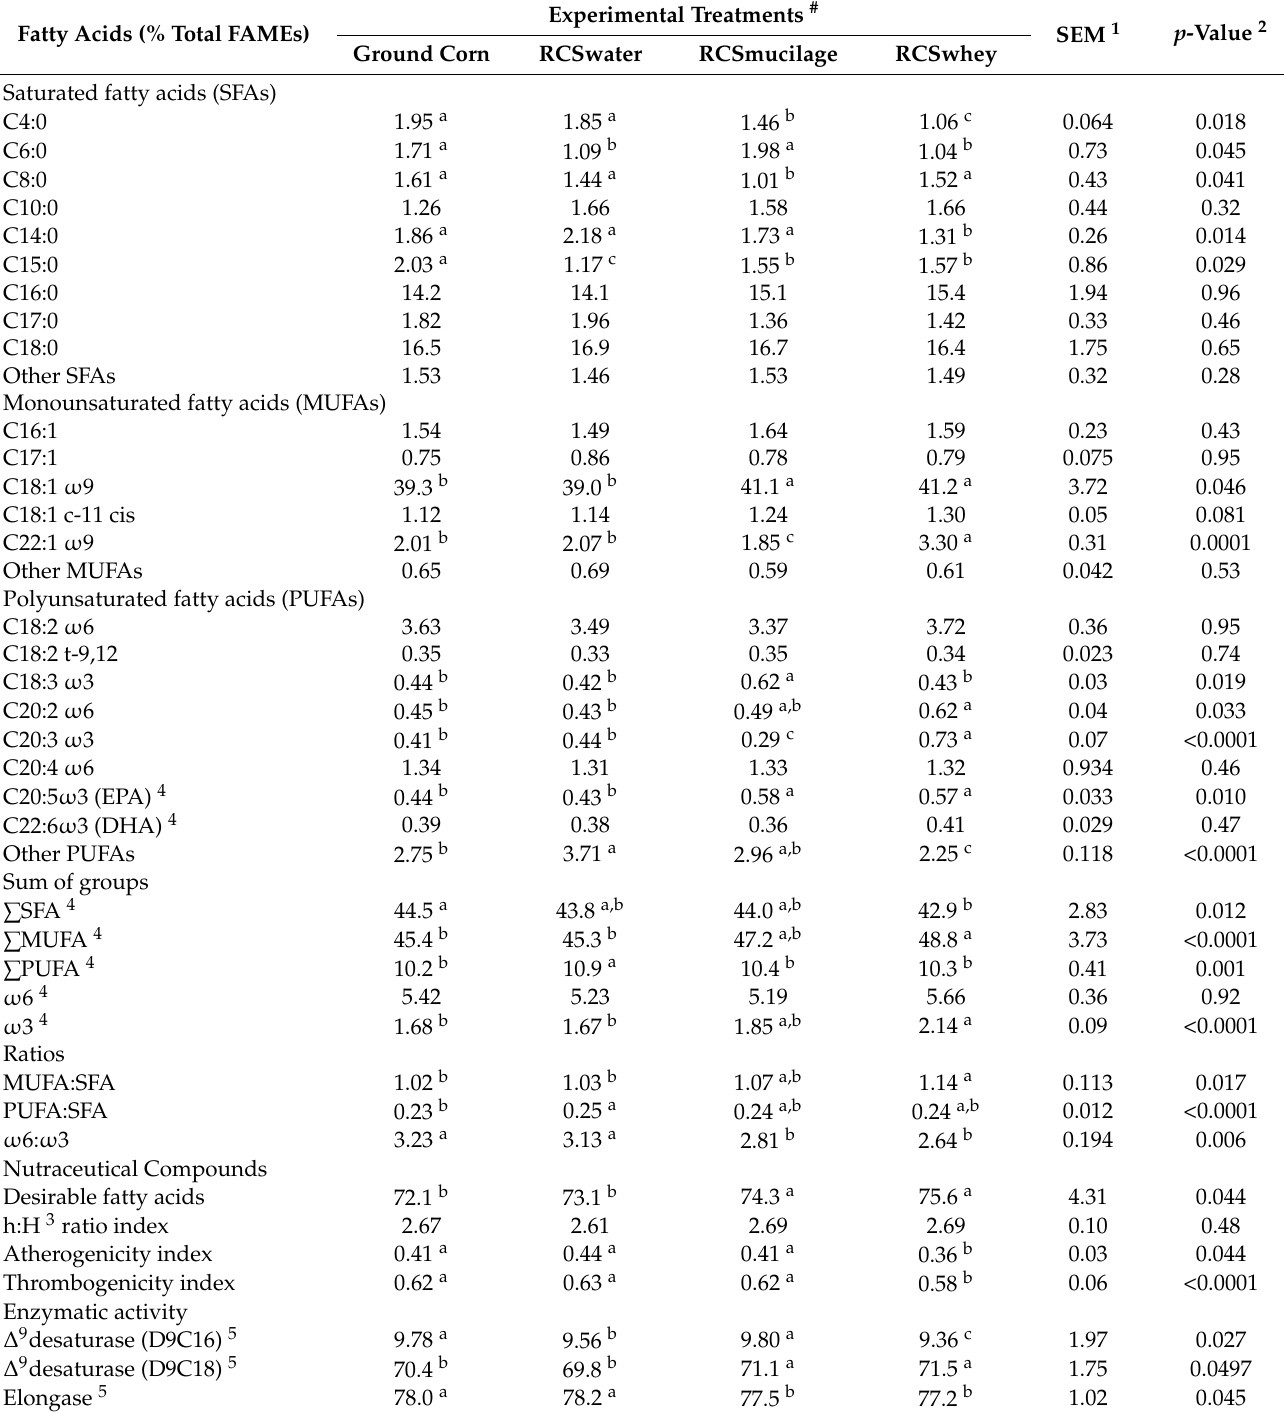
Table 5. Fatty acid profile of longissimus lumborum muscle of goat kids fed with dry corn grain and ground-corn-grain silage rehydrated with the different